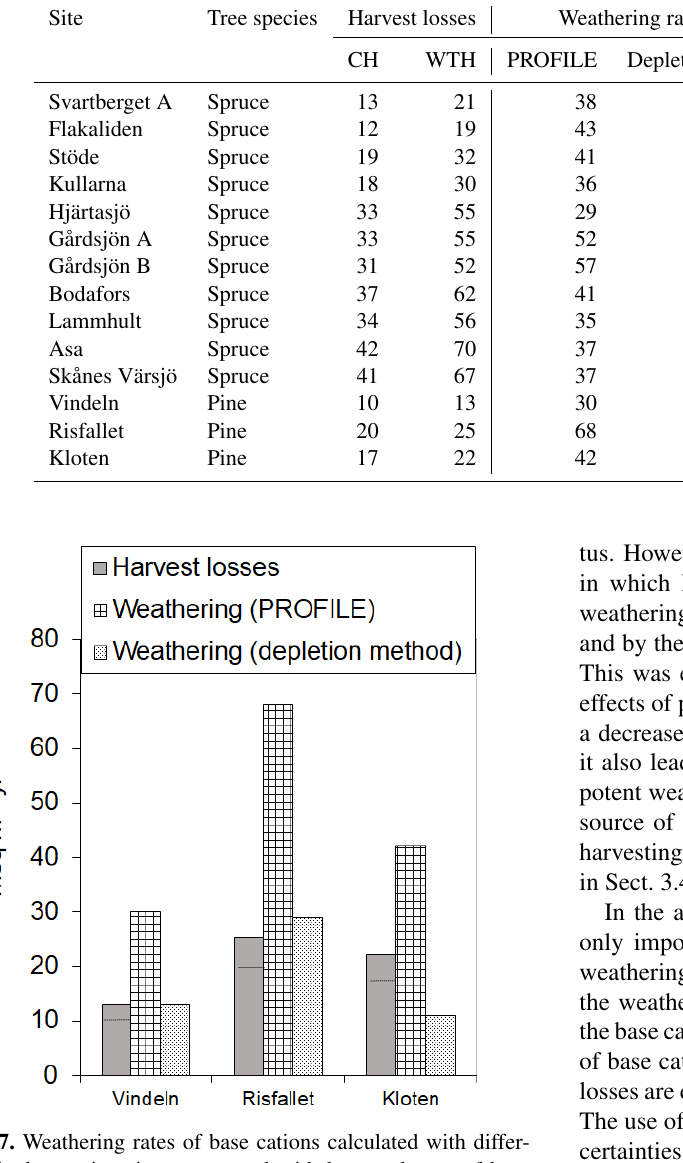
Table 5. Weathering rates estimated with different approaches and harvest losses at conventional harvesting (CH, only stems) and whole-tree harvesting (WTH, stems and branches) (meqm − 2 yr − 1 ).